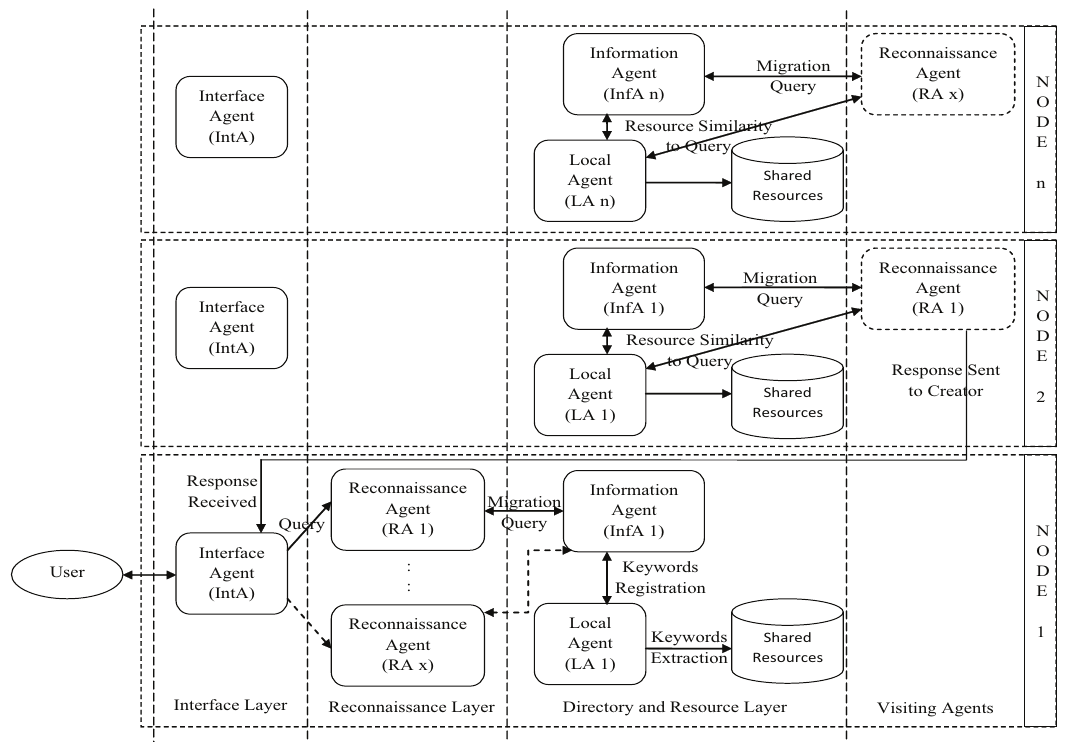
Fig. 1. Global architecture of the